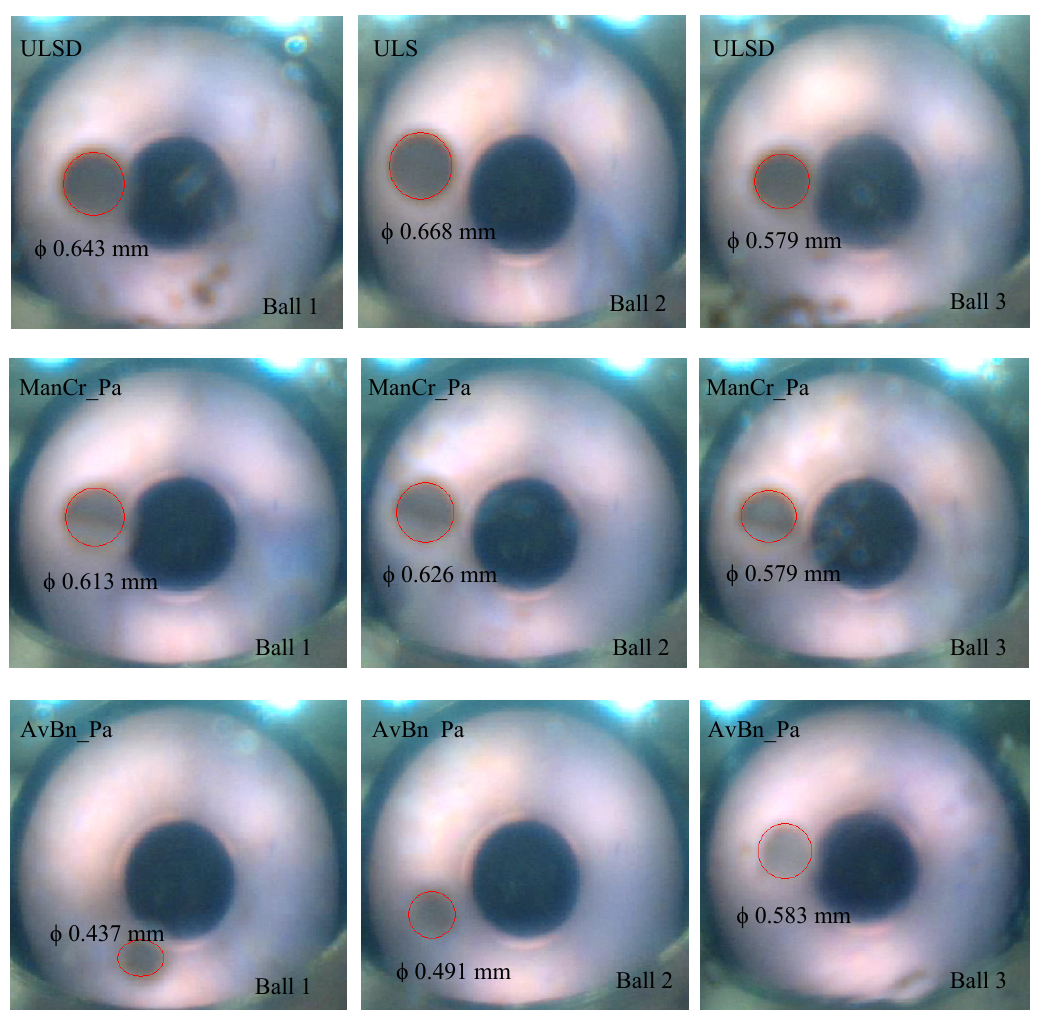
Figure 7. Optical microscope scanning image for wear scar diameter of the three stationary balls.